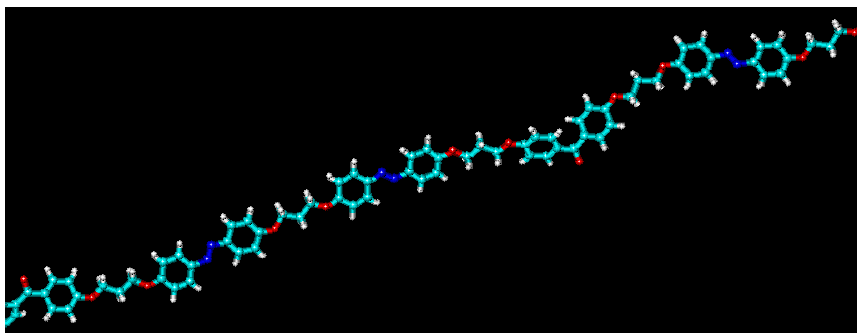
Fig. 2 Chain geometry corresponding to Sample 2.